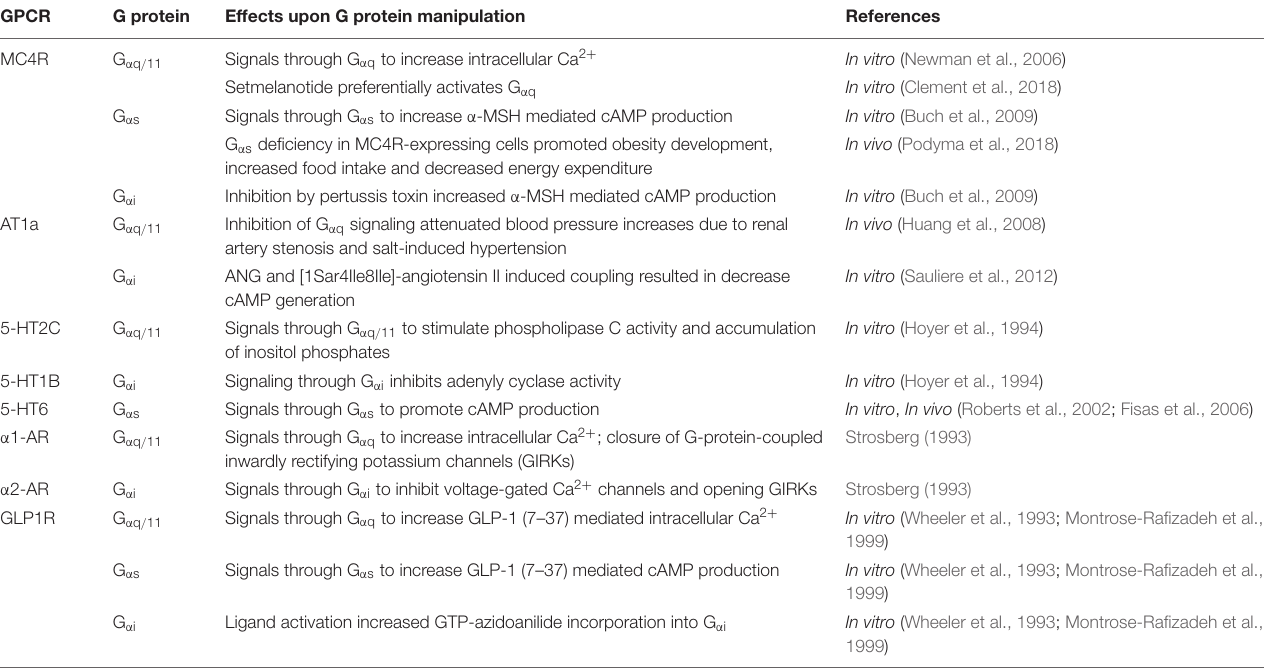
TABLE 1 | The downstream signaling effects of hypothalamic GPCRs involved in the cardiometabolic